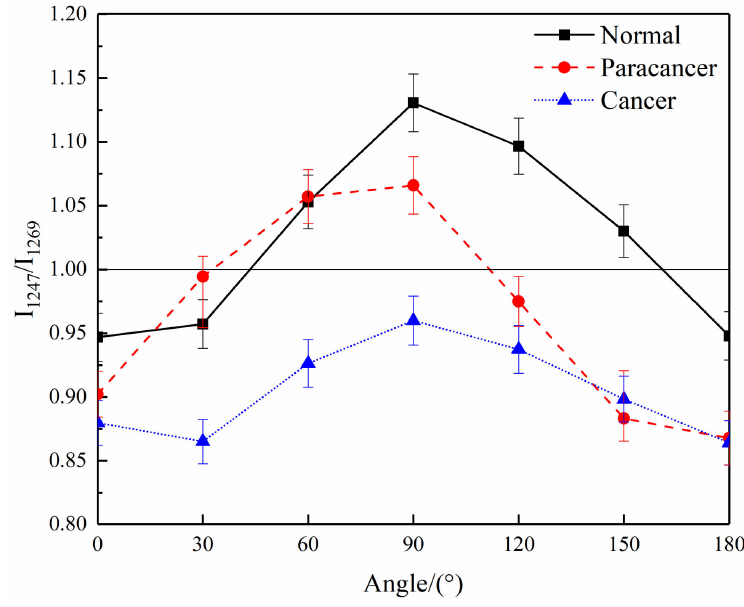
Figure 6. The trends of the bimodal ratio (I 1247 /I 1269 ) in the spectra of cancerous, paracancerous and normal breast tissues with the polarization